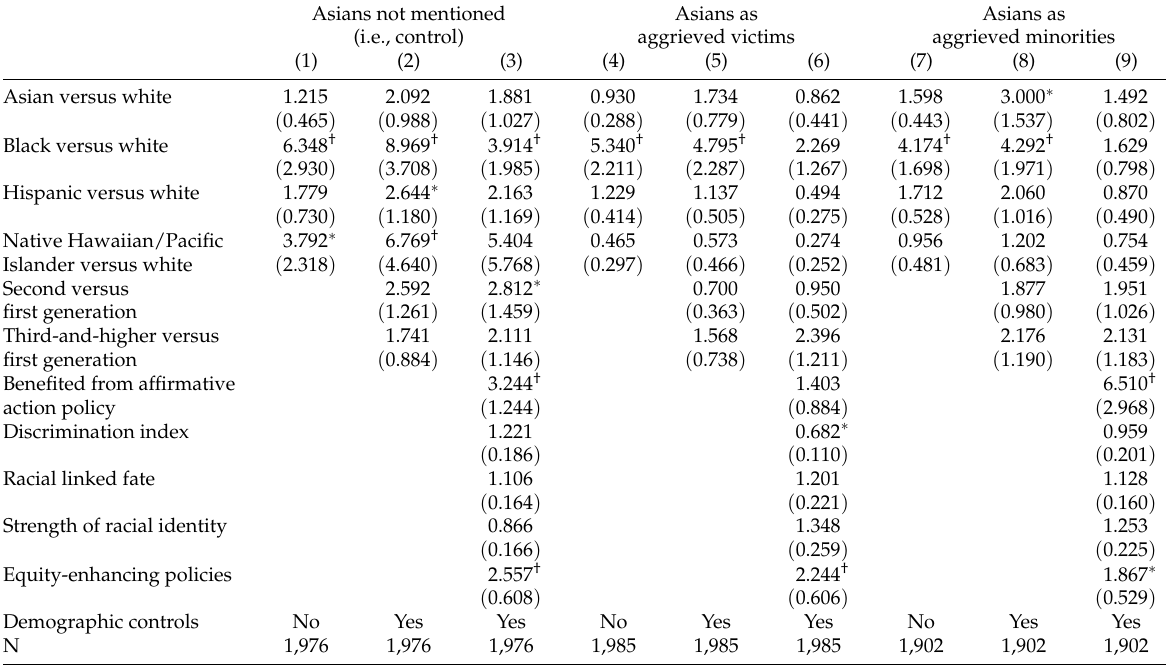
Table 2: Selected variables from multinomial logistic regressions on preference for hiring and promotion by frame: support versus oppose. Source: 2016 National Asian American